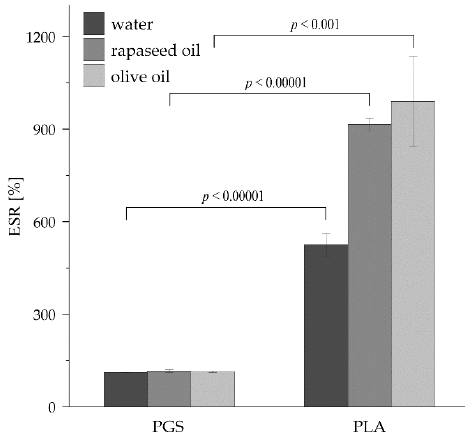
Figure 4. The ESR values of water, rapeseed oil, and olive oil estimated for studied constructs made of PGS and PLA. The p values over brackets were determined according to the s tudent’s t -test.